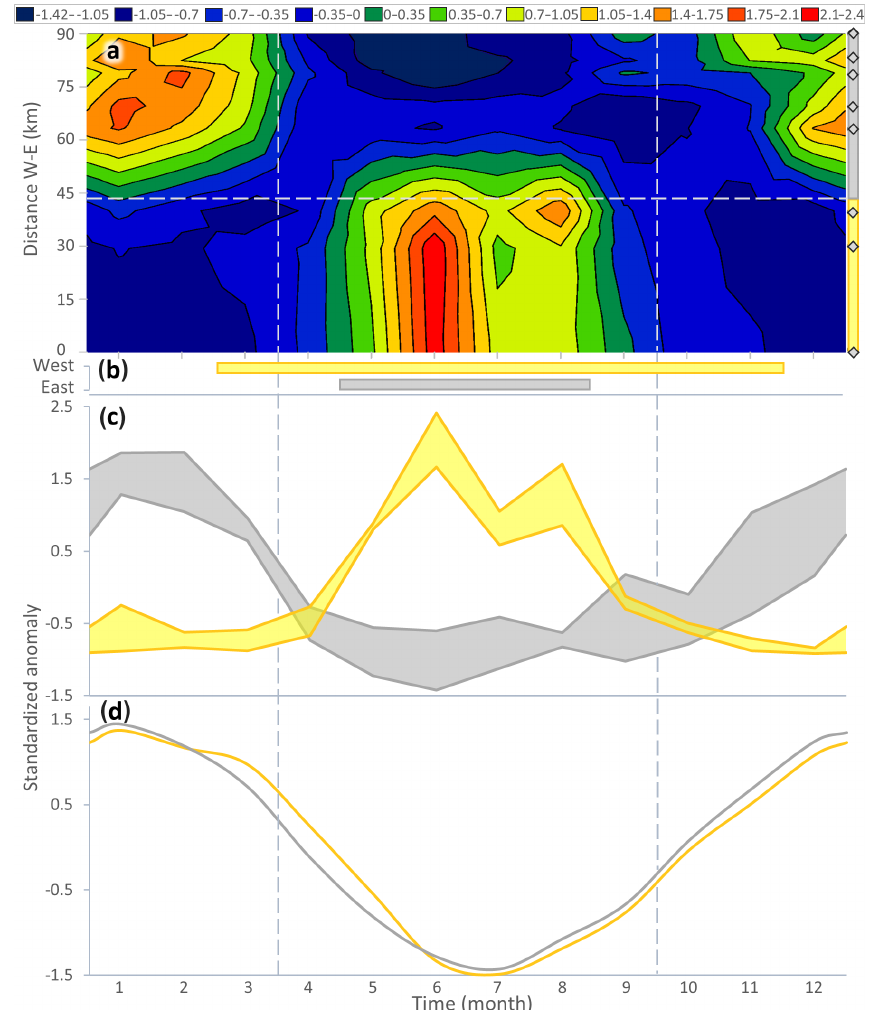
Figure 2. Mean annual cycles of selected variables. (a) Monthly mean standardized precipitation along a west–east transect. The vertical axis indicates the distance eastward from the Andes ridge. Diamonds indicate the stations’ positions, vertical lines the seasonal division and horizontal line the longitudinal division. (b) Periods of prevailing precipitation by frontal systems in each zone. (c) Range of monthly mean standardized precipitation considering the stations in each zone. (d) Mean average standardized temperature in each zone. In (b–d) yellow (grey) lines refers to the W (E) zone.